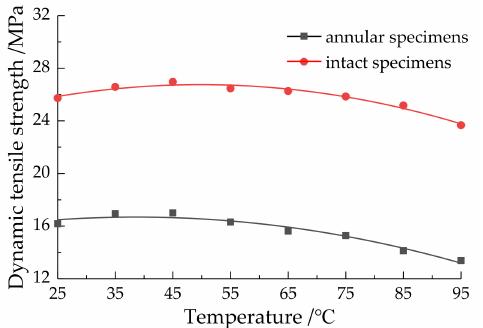
Figure 9. Relationship between dynamic tensile strength and water temperature.